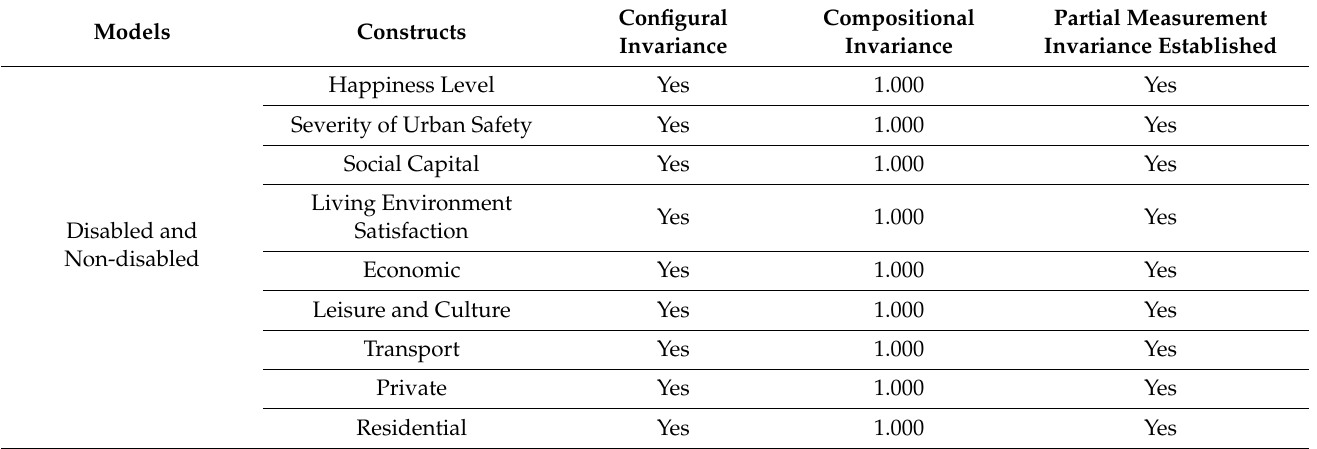
Table 6. Measurement invariance test results of models (disabled and